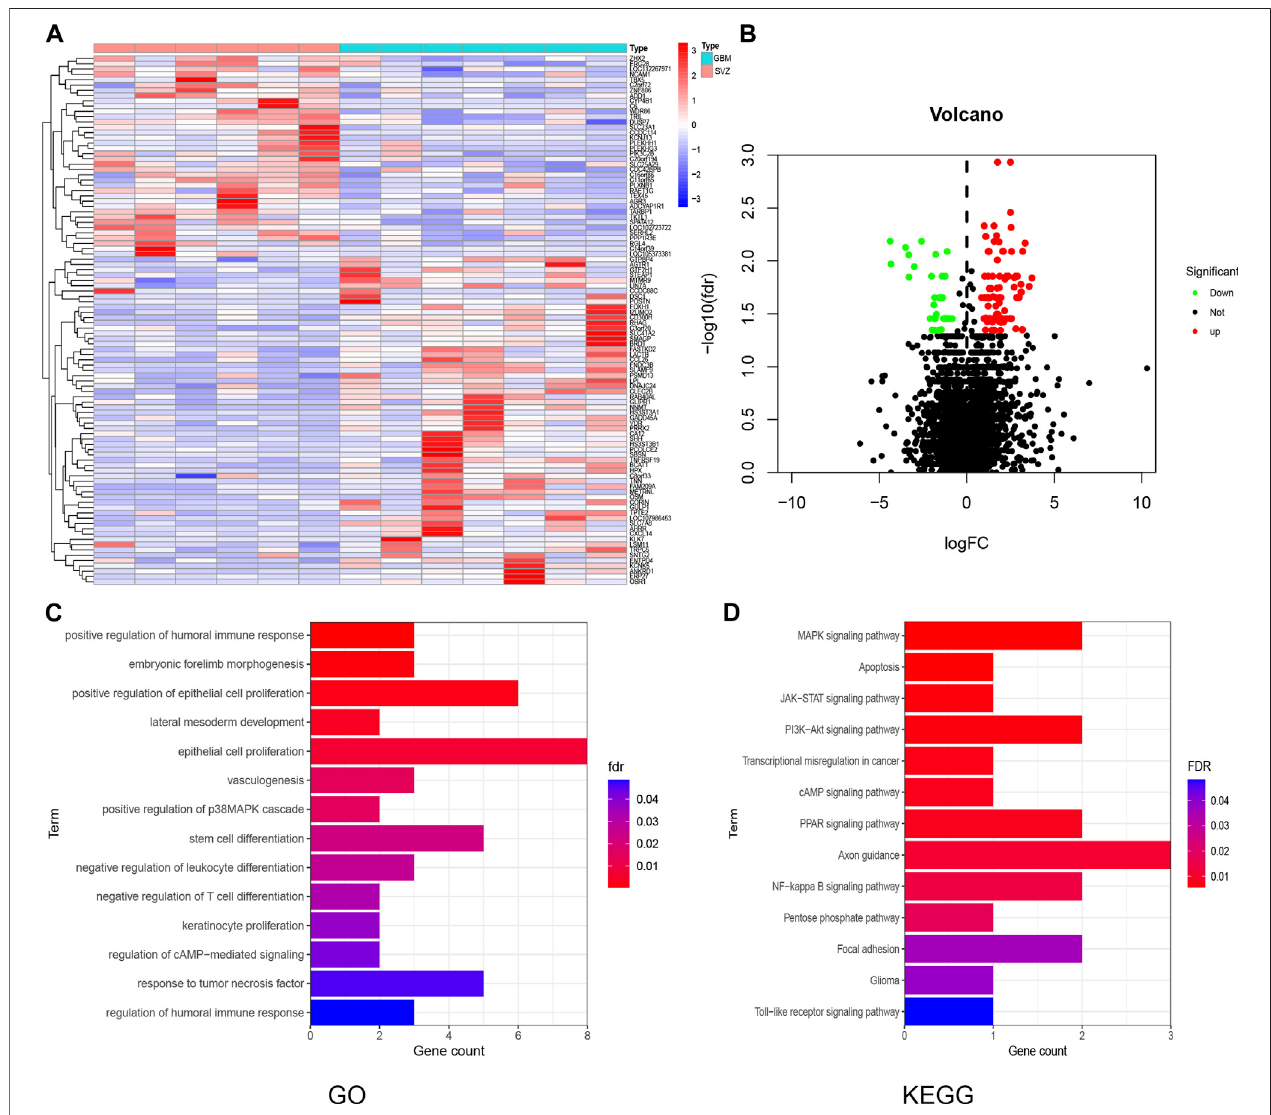
FIGURE 2 | DEG and enrichment analysis for SVZ and GBM. (A) Heatmap for DEGs generated by comparison of the SVZ vs. GBM. Row name of headman is the gene name, and the column name is the ID of samples which not showed in a plot. (B) Volcano map of distribution of DEGs. Red point shows up-regulated DEGs while green shows down-regulated in GBM compared with SVZ. (C,D) GO and KEGG analysis for these DEGs in GBM.